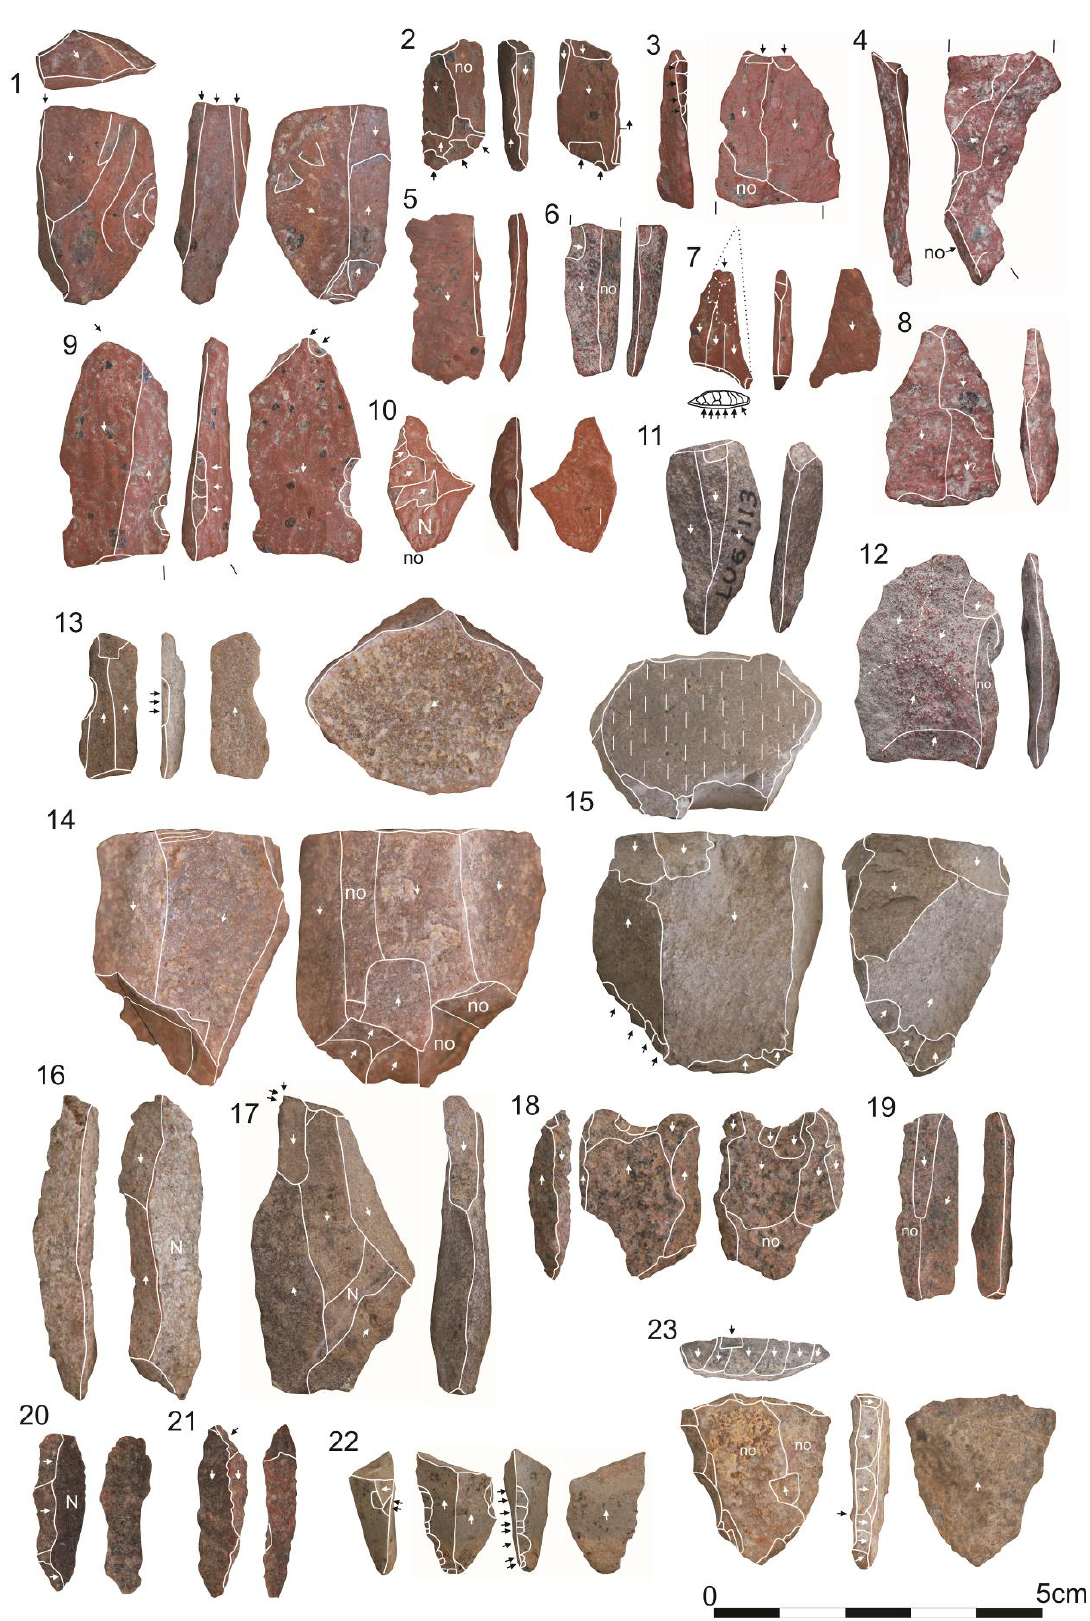
Figure 5. Stone artefacts from the Ludowice 6 site: quartz porphyry (1-10), quartzite sandstone (11-17), granite (18-21), quartzite